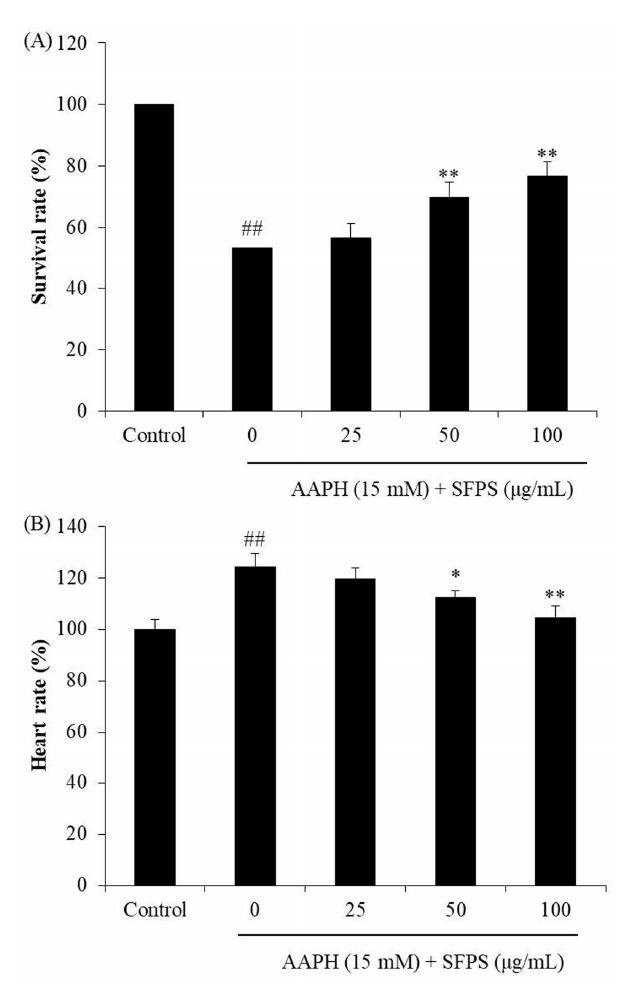
Figure 4. The survival rates and heart rates of zebrafish after pretreatment with SFPS and/or treatment with AAPH: ( A ) survival rate and ( B ) heart rate. The data are expressed as means ± SE ( n = 3). * p < 0.05, ** p < 0.01 as compared to the AAPH-treated group and ## p < 0.01 as compared to the control